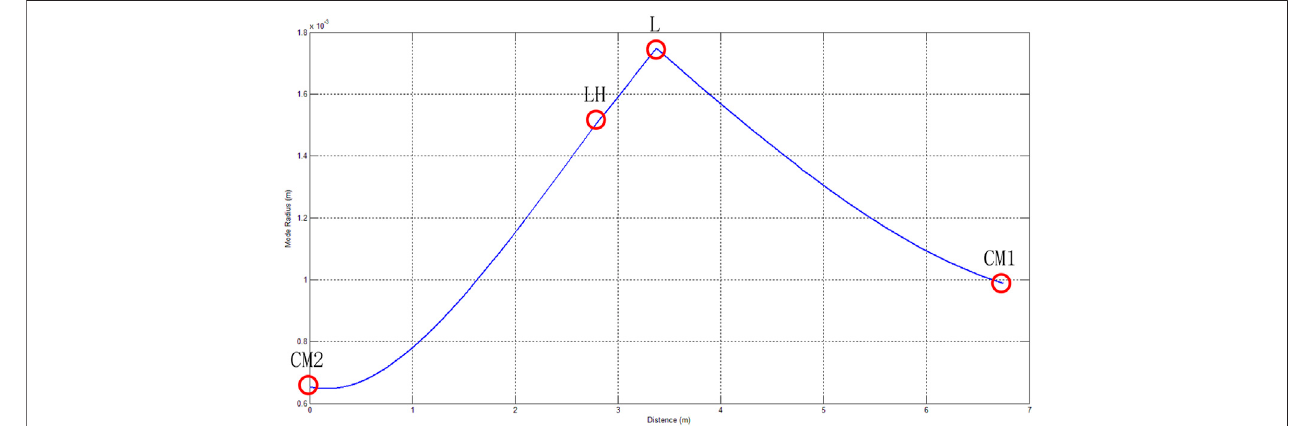
FIGURE 7 | Mode size of the regenerative cavity.